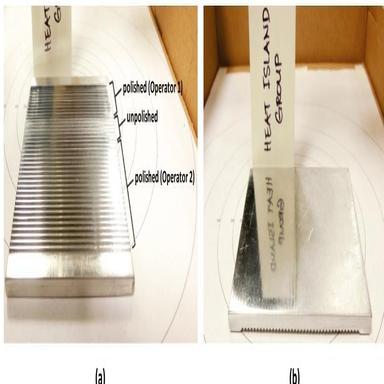
Polished orthogonal groove aluminum block, showing sections of the grooves in the front face polished by two different operators (a) and the rear face smoothed by one of the operators (b).